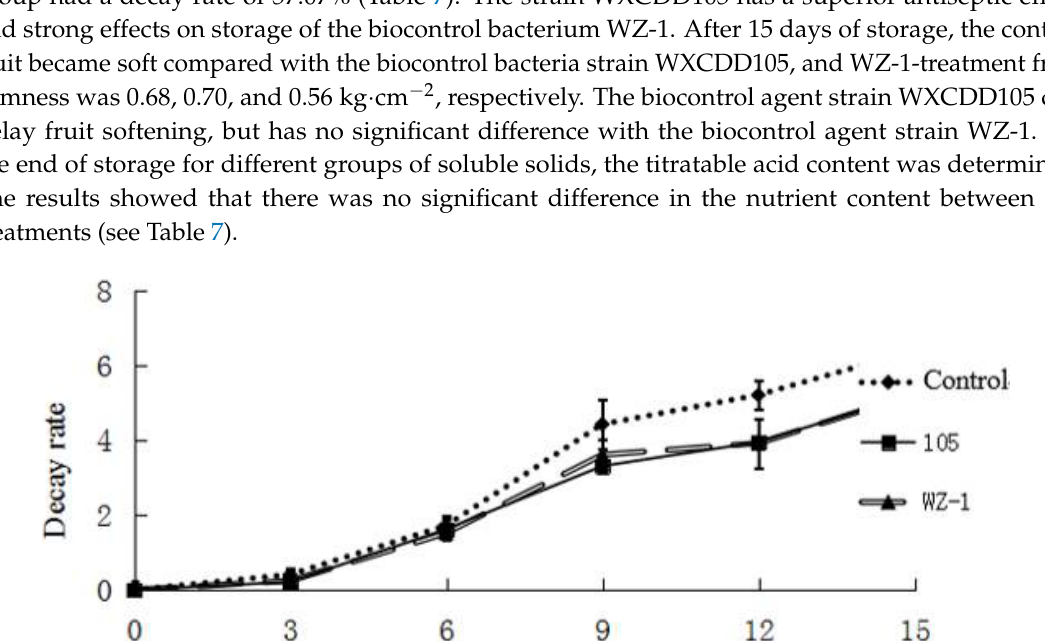
Table 6. The growth-promoting effect of single strain WXCDD105 on tomato seedlings.